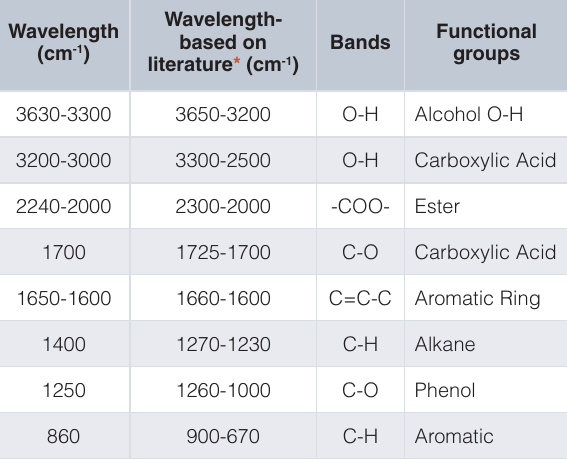
Figure 5. Molecular structure of polyethylene terephthalate (PET) 16 .